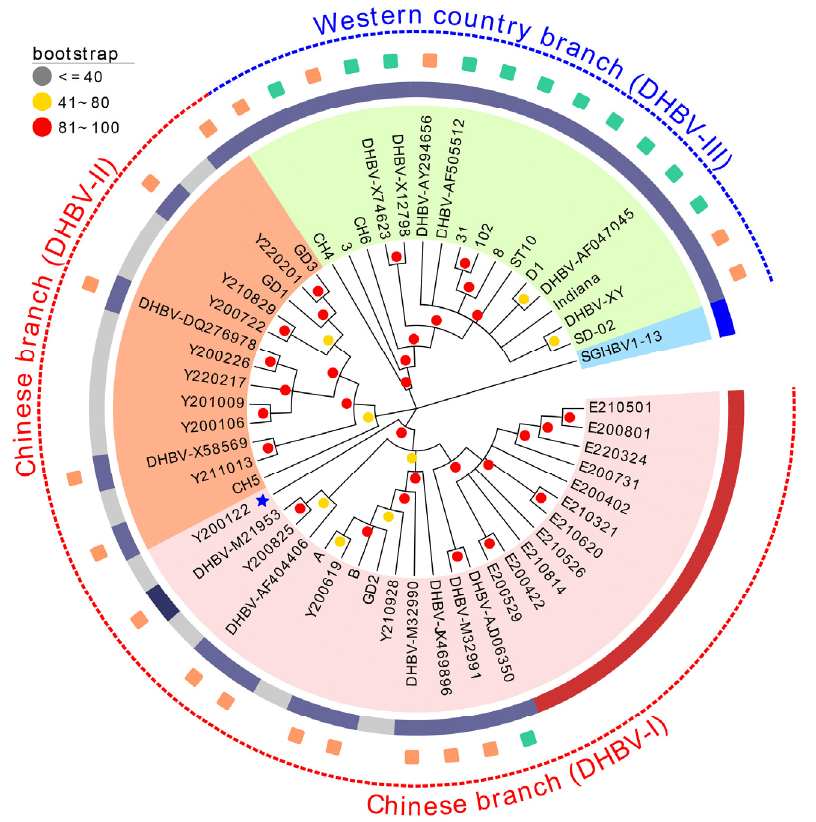
Figure 3. The DHBV phylogenetic tree based on the entire genome. In maximum likelihood analysis using MEGA X, the filled circles along the branches represent bootstrap values. Blue and red dotted lines represent the foreign and Chinese strains, respectively. Green and orange squares represent the Western and Chinese reference strains, respectively. The dark blue and gray solid rings represent the reference and research strains, respectively. Blue pentagrams denote recombinant strains.